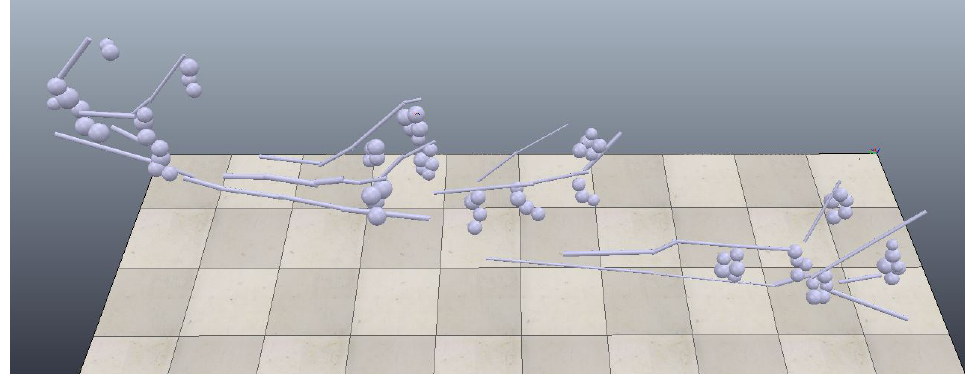
Figure 8. Simulation environment.